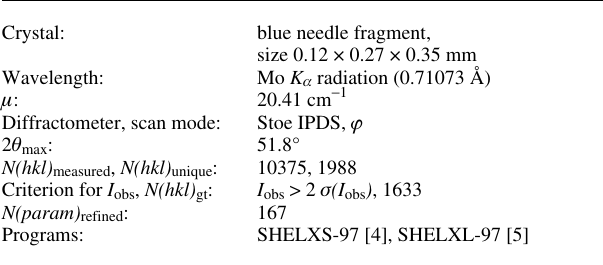
Table 1. Data collection and